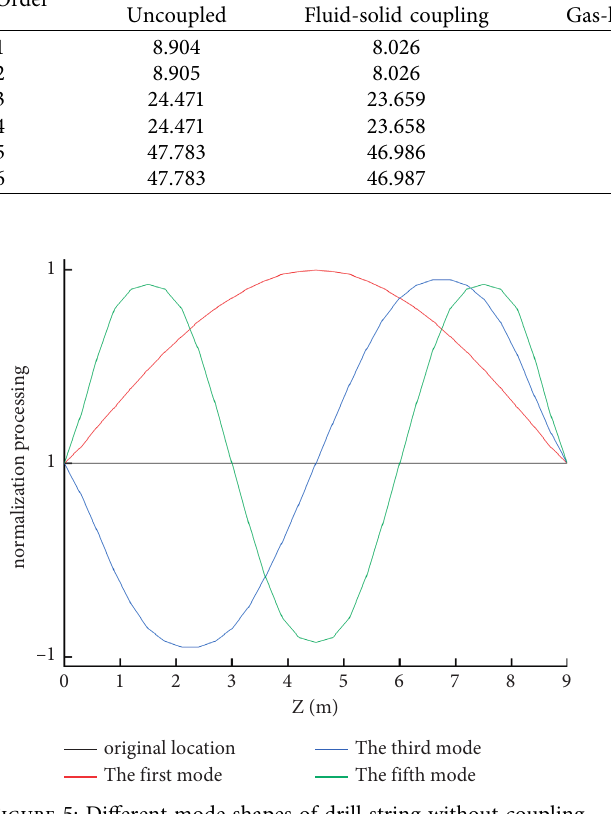
Figure 5: Different mode shapes of drill string without coupling.